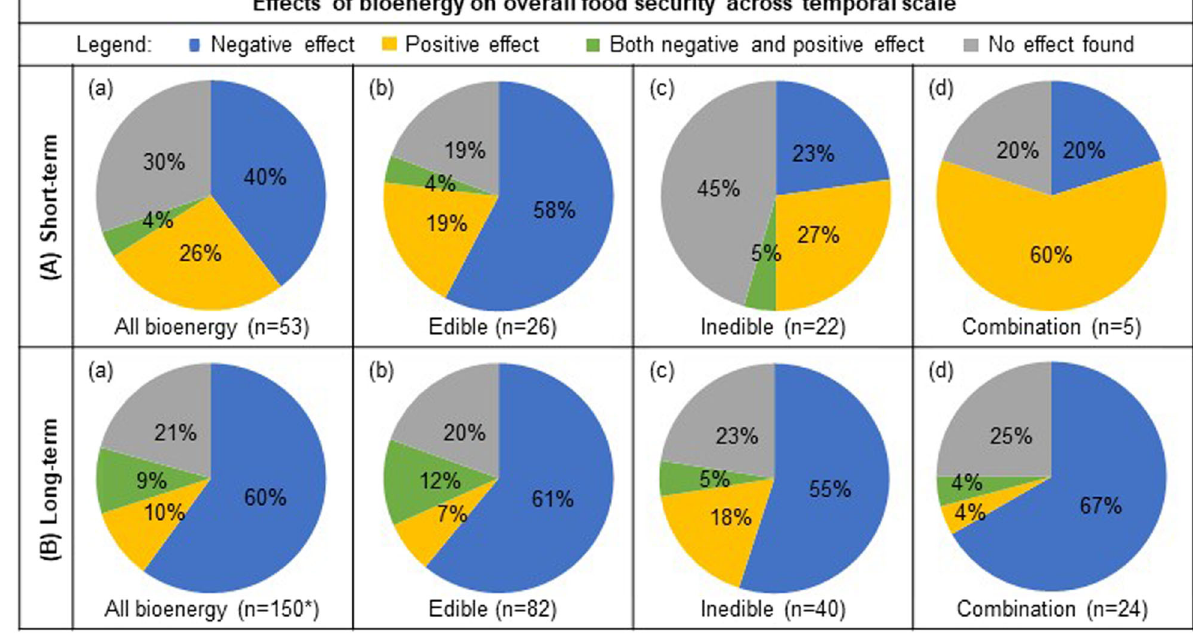
Fig. 6 Effects of bioenergy on food security across the temporal scale. Percentage of reviewed publications that reported either negative, positive, both negative and positive, or neutral effect of all bioenergy (column a ), edible ( b ), inedible ( c ), and studies that included a combination of both edible and inedible feedstocks in their analysis ( d ) from short-term (row A ) and long-term scales ( B ). *Bioenergy type “ not speci fi ed ” ( n = 4) is only included in “ All bioenergy ” (column a), and therefore the sum of edible, inedible, and both edible and inedible (columns b – d ) will not necessarily be a composite of “ All bioenergy ” . Studies that included a combination of both short- and long-term scales, or where the temporal scale was not speci fi ed, are not included in the fi